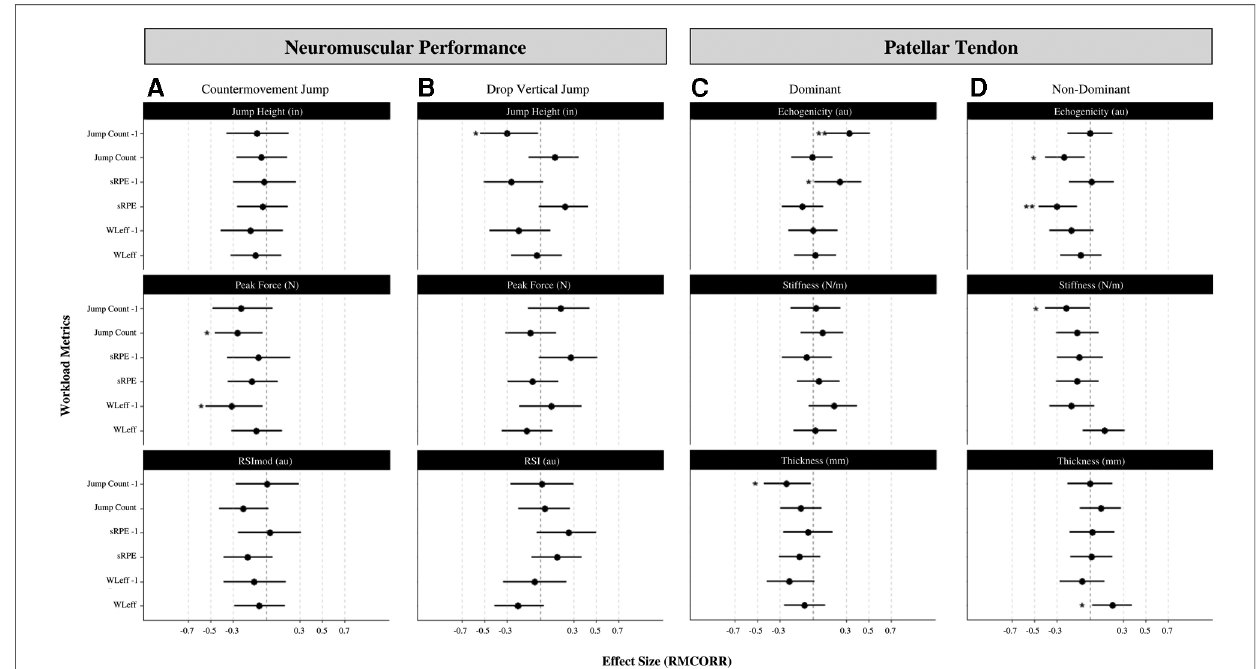
FIGURE 4 Effect sizes of RMCORR between ( A ) countermovement jump and workload, ( B ) drop vertical jump and workload, ( C ) dominant patellar tendon and workload, ( D ) non-dominant patellar tendon and workload. * p <0.05, ** p <0.01. sRPE, session rating of perceived exertion; WLeff, workload ef fi ciency, − 1 indicates time-lagged variable.